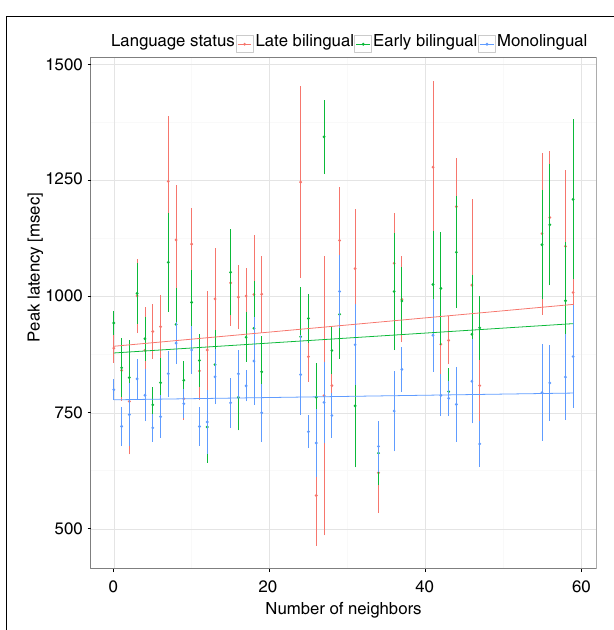
FIGURE 4 | Peak latencies as a function of neighborhood density. Vertical lines and dots show the mean and standard error of individual items. Regression lines show the best fit for each group.